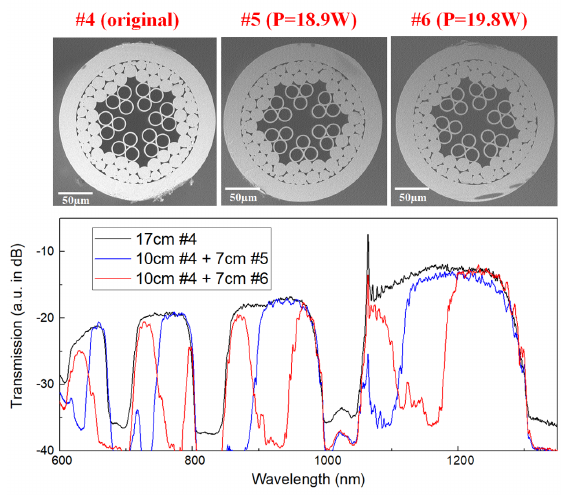
Figure 6. Transmission spectra of different fiber combinations. Fiber #4: unprocessed fiber, t = 1.97 µ m; Fiber #5: processed under P = 18.9 W, t = 2.09 µ m; Fiber #6: processed under P = 19.8 W, t = 2.21 µ